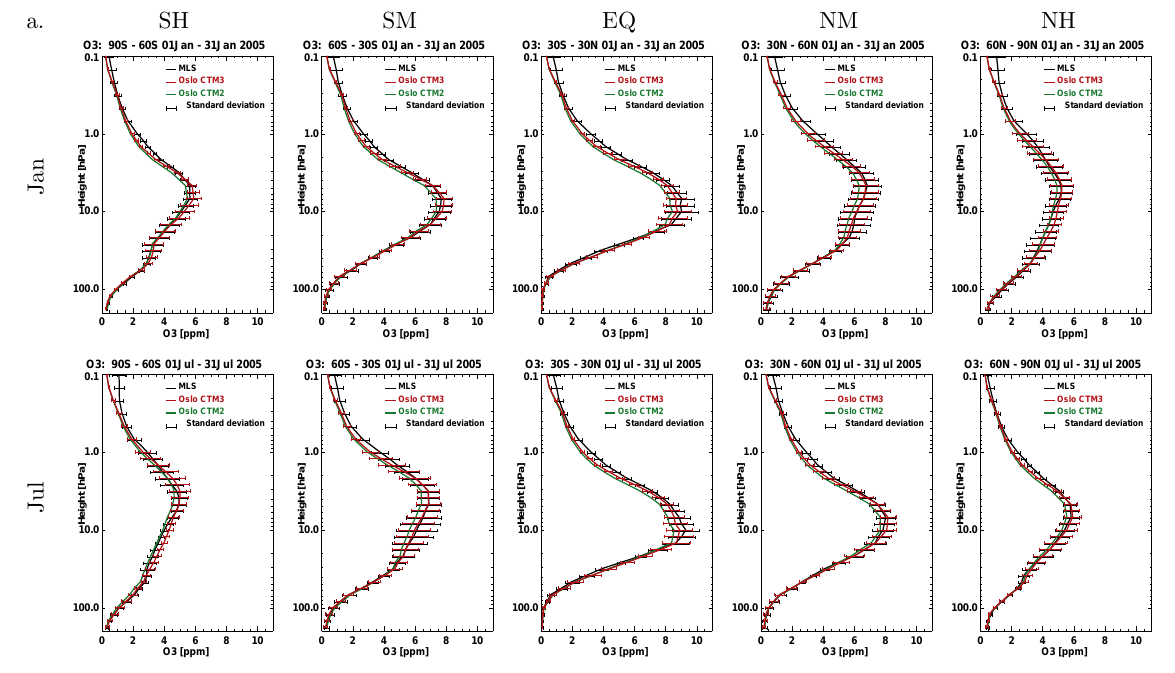
Fig. 7. Comparison of O 3 (a) , HNO 3 (b) , and N 2 O (c) from CTM3 (C3 ssn), CTM2 (C2 ssn) and MLS, as vertical profiles of zonal monthly means covering the latitude bands 90 ◦ S–60 ◦ S (southern high, column “SH”), 60 ◦ S–30 ◦ S (southern mid-lat, column “SM”), 30 ◦ S–30 ◦ N (“EQ”), 30 ◦ N–60 ◦ N (“NM”) and 60 ◦ N–90 ◦ N (“NH”) for January 2005 and July 2005. Model profiles are processed with the MLS averaging kernel and a-priori